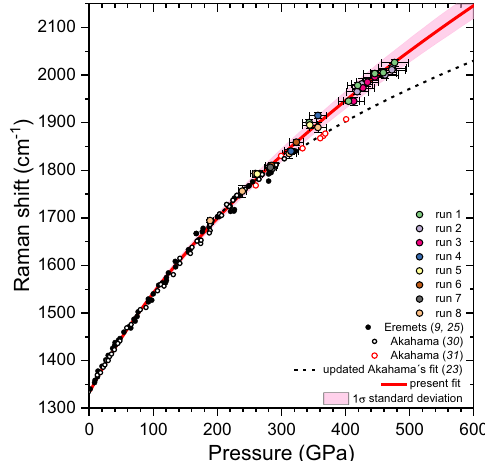
Fig. 2 | The universal diamond edge Raman scale. Large colorful circles corre- spond to the pressure dependence of the high-wavenumber Raman edge of the stressed diamond anvil measured in runs 1 – 8 of the present study. Error bars represent uncertainties in estimation of pressure values using equation of state of Au 23 and determination ofthe mid-pointof the diamond high-wavenumber Raman edge.Smallblackcirclesarethedatafromrefs. 9,25 (pressuresvalueswereestimated using the ruby scale 24,25 below ∼ 200GPa and equation of state of Au 63 above ∼ 200GPa). Open black and red circles correspond to the data from refs. 30,31 after correctingthepressurevaluesusingtherecentrampcompressiondataofPt 23 .The solidredcurve fi tsthecombinedexperimentaldataset,includingthepreviousdata measured below ∼ 300GPa 9,25,30 , and magenta area shows 1 σ standard deviation (see SupplementaryTable 1).The blackdotted curveisthe updated diamond edge Ramanscale ofAkahama 23 forthe high-pressurerangeabove200GPa.Source data are provided as a Source Data fi